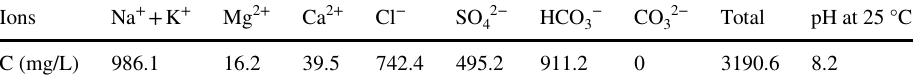
Table 1 Ion composition of the simulation water